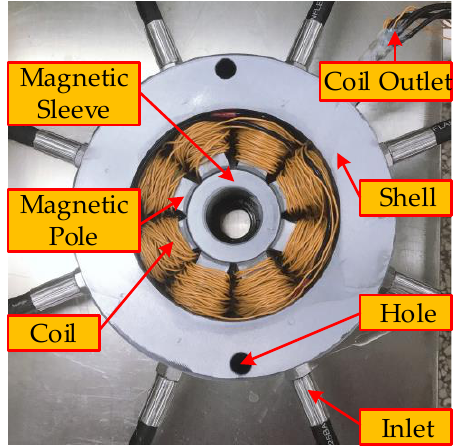
Figure 4. Photo of Radial Journal Unit of MLDSB.